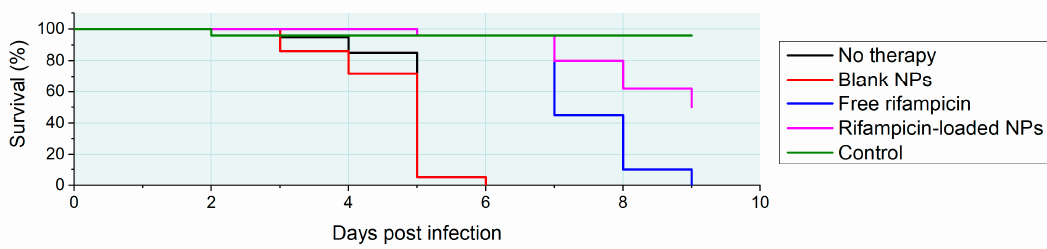
Figure 9. In vivo testing of antituberculotic nanobead-based intervention. Zebrafish larvae were infected with Mycobacterium marinum and treated with free rifampicin, rifampicin-loaded nanoparticles and blank nanoparticles at a dose of 10 mg / kg. Cumulative mortality is shown. Modified based on data from reference [142].